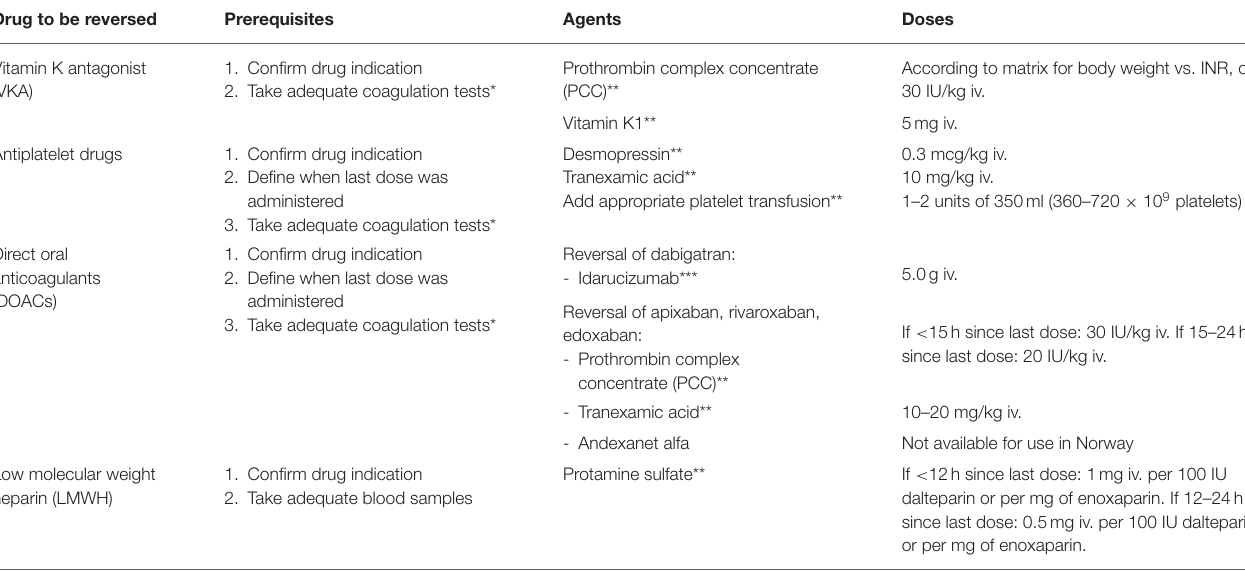
TABLE 1 | Protocol for complete or partial reversal of antithrombotic drugs at OUH-U following trauma or TBI with severe bleeding. Drug to be reversed Prerequisites Agents